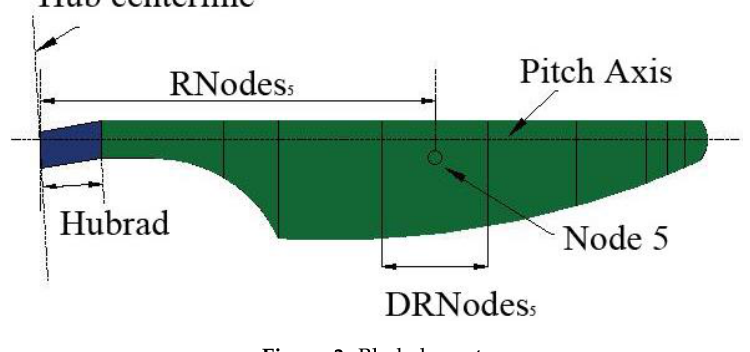
Figure 3. Blade layout. Figure 3. Blade Table 1. Overall parameters of NREL 5 MW wind turbine system.